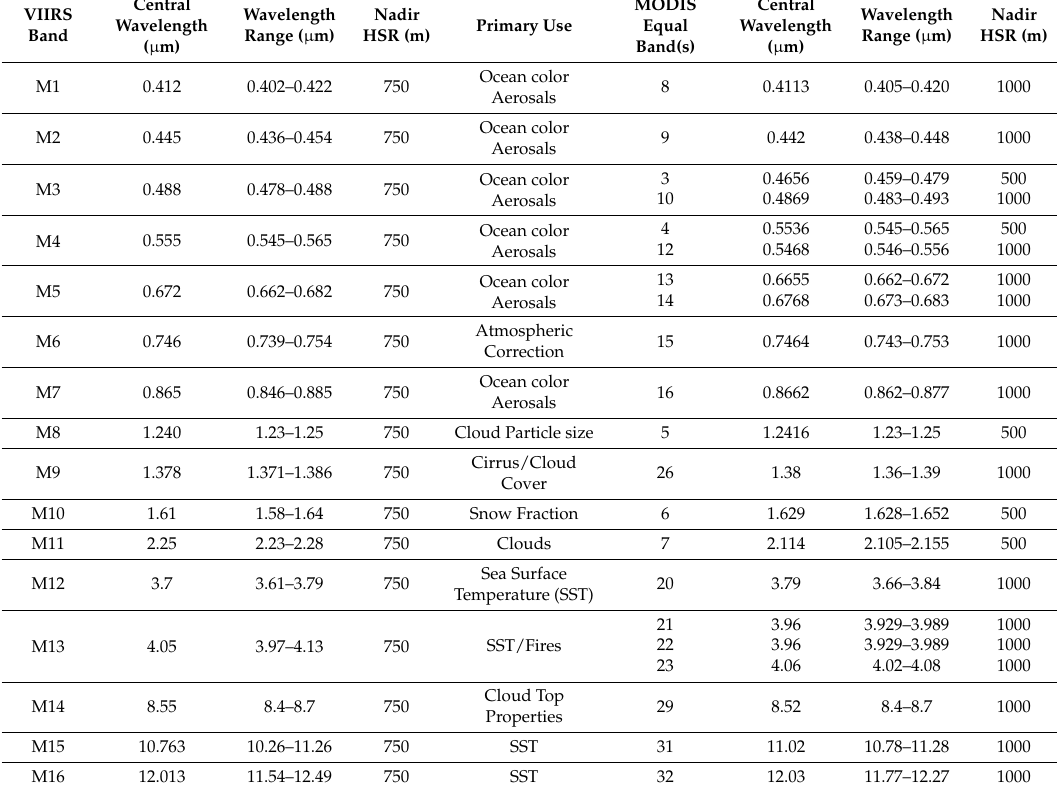
Table 1. Visible Infrared Imaging Radiometer Suite (VIIRS) Spectral Bands (M) and Moderate Resolution Imaging Spectroradiometer (MODIS) Equivalent Bands (M for Moderate spatial resolution; HSR for Horizontal Spatial